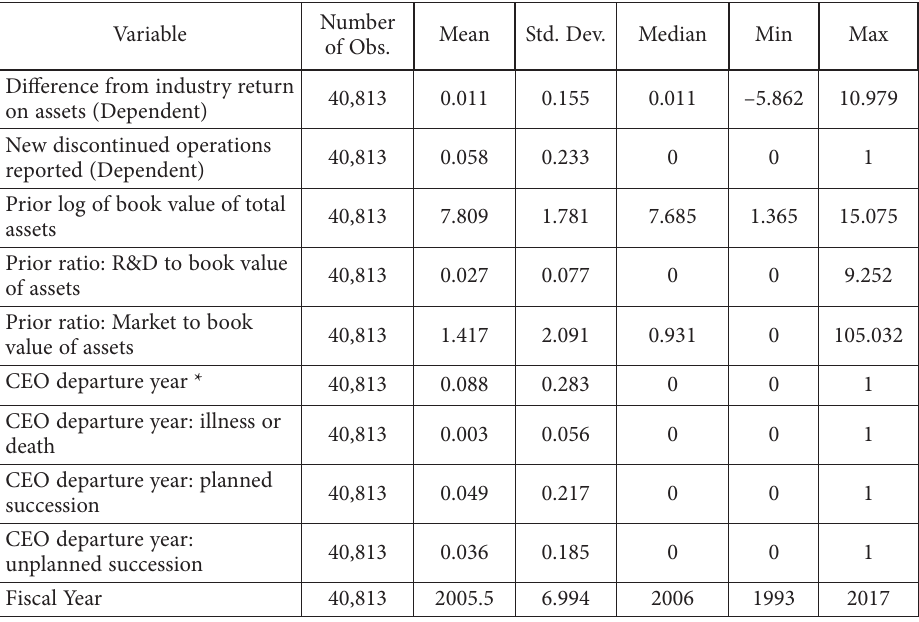
Table 3. Summary